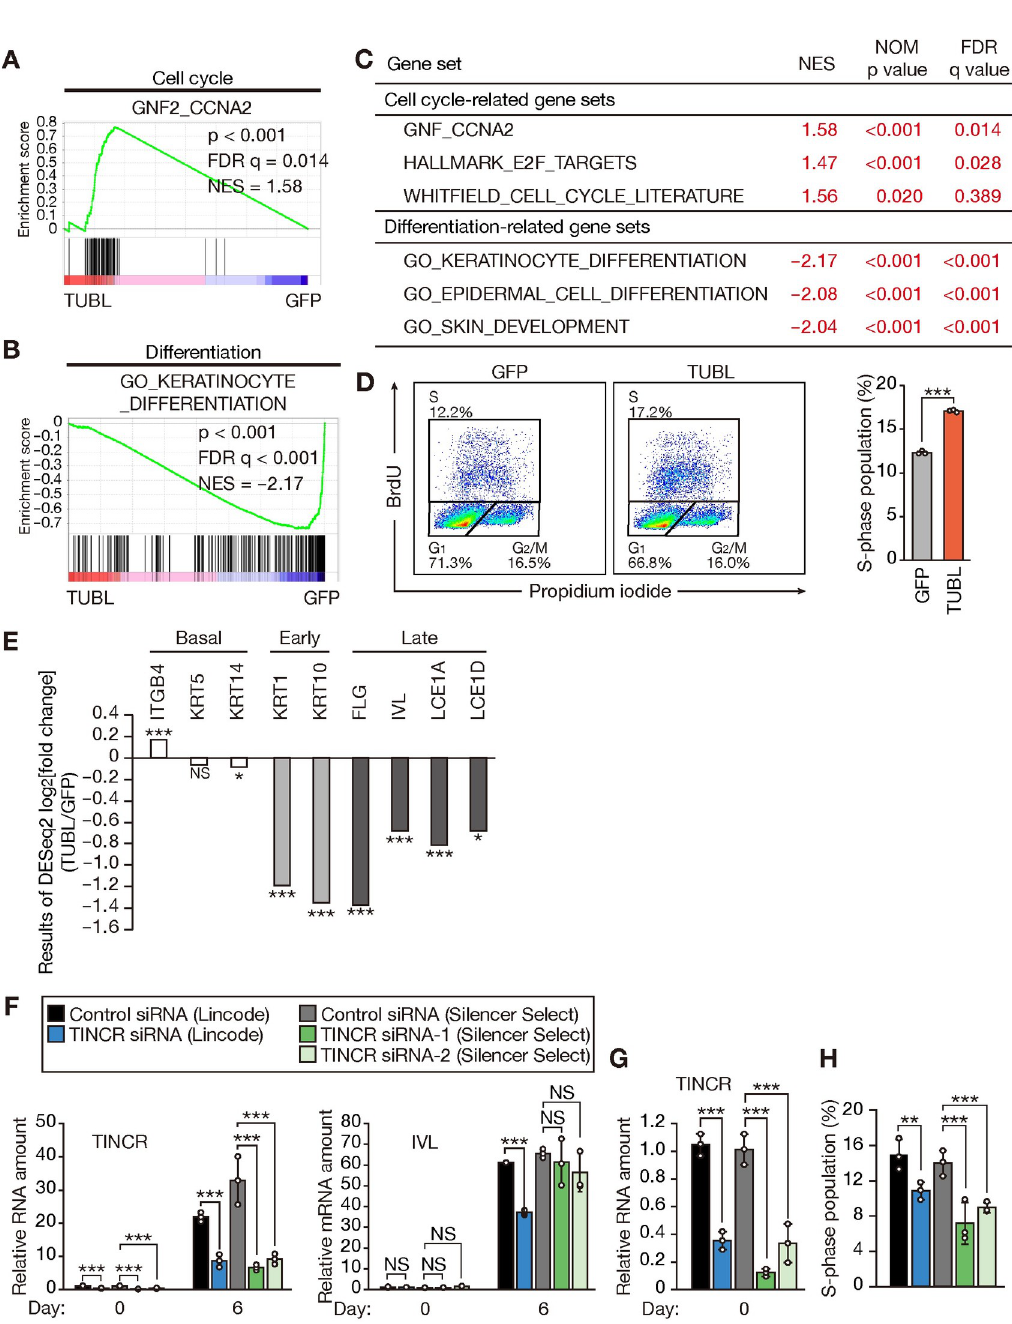
Fig 2. TUBL expression promotes cell cycle progression and inhibits differentiation in human keratinocytes. (A, B) GSEA plots for gene sets related to the cell cycle (A) or keratinocyte differentiation (B) constructed from RNA-seq data obtained for NHEKs expressing GFP or human TUBL. FDR, false discovery rate; NES, normalized enrichment score. (C) Summary of GSEA results for gene sets related to the cell cycle or keratinocyte differentiation. NOM, nominal. (D) Flow cytometric traces and quantification of BrdU incorporation for NHEKs stably expressing GFP or TUBL. Data in the right panel are means ± SD (n = 3 independent experiments). ��� p < 0.005 (Student’s t test). (E) RNA-seq results for differentially expressed genes related to basal, early, or late keratinocyte differentiation. The results for NHEKs expressing TUBL were normalized by those for NHEKs expressing GFP. � p < 0.05, ��� p < 0.005; NS, not significant (adjusted p values). (F, G) RT-qPCR analysis of TINCR and involucrin (IVL) mRNA abundance in NHEKs transfected with the indicated control or TINCR siRNAs for 1 day and then subjected to calcium-induced differentiation for 0 or 6 days (F). The results for TINCR abundance at day 0 of differentiation are expanded in (G). Data are means ± SD (n = 3 independent experiments). ��� p < 0.005, NS (Student’s t test). (H) Quantification of BrdU incorporation for NHEKs transfected with the indicated control or TINCR siRNAs for 2 days. Data are means ± SD (n = 3 independent experiments). �� p < 0.01, ��� p < 0.005 (Student’s t